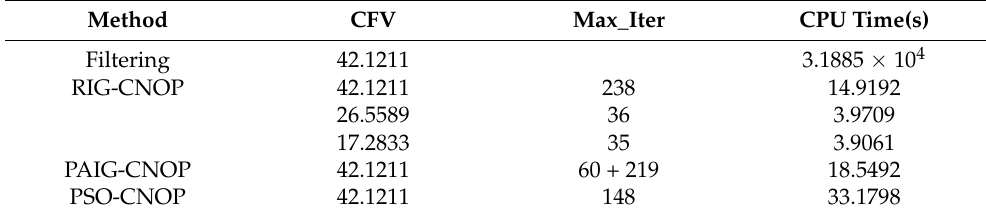
Table A2. Comparison of the maximum number of iterations (max_iter) and CPU time between the 4 different methods when at point B , T =